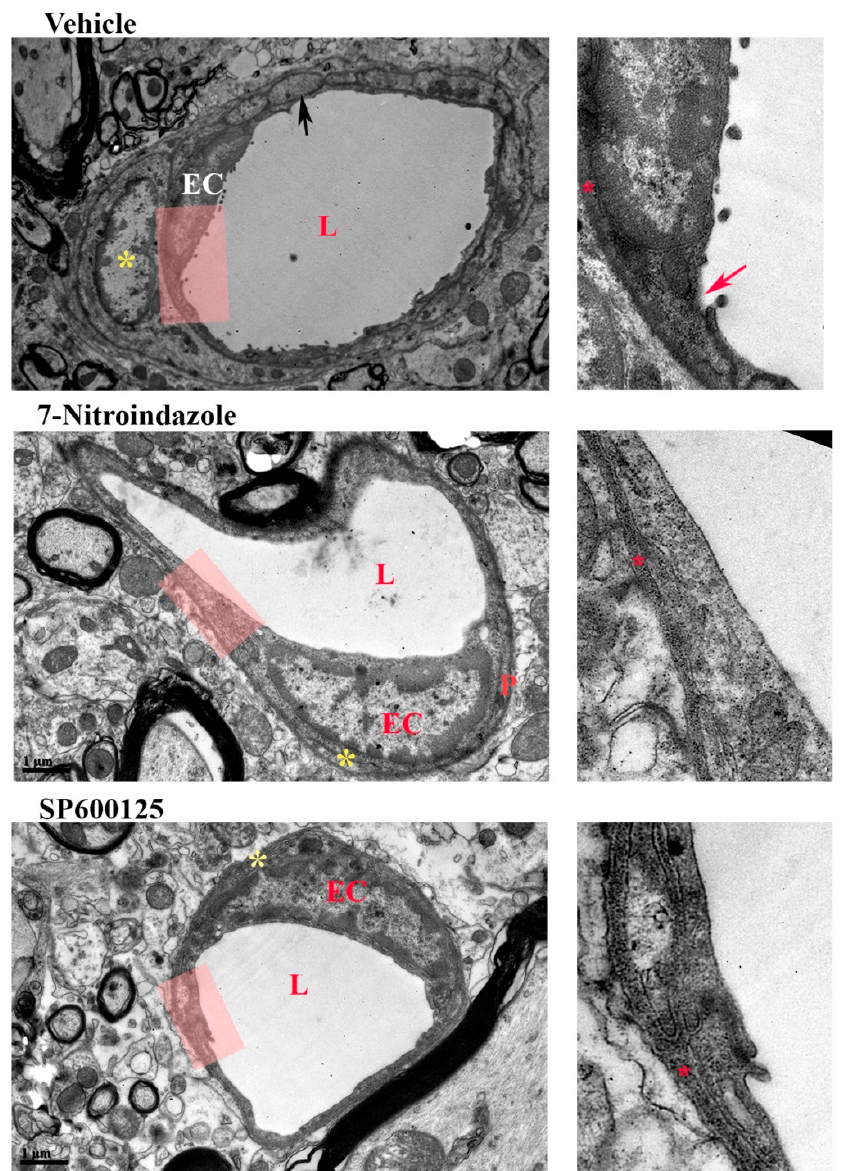
Figure 7. Neurovascular unit. Electron microscopy showing representative spinal cord microvessels in the left C7 ventral horn of rats injected with either vehicle, JNK inhibitor SP600125, or 7-nitroindazole. Magnification 9700 × and 18,500 × . Scale bar: 1 µ m. L = lumen, EC = endothelial cell. Red arrow- disruption of endothelial membrane. Red star (*) = basement membrane. Yellow star * = pericyte.